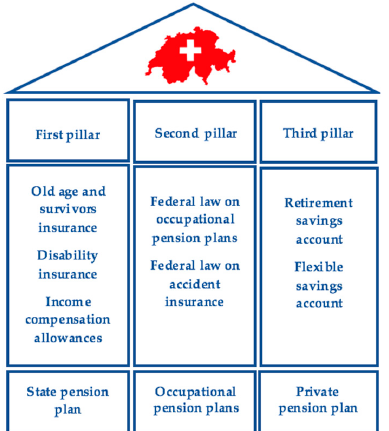
Figure 1. Swiss pension plan system (Swissinfo